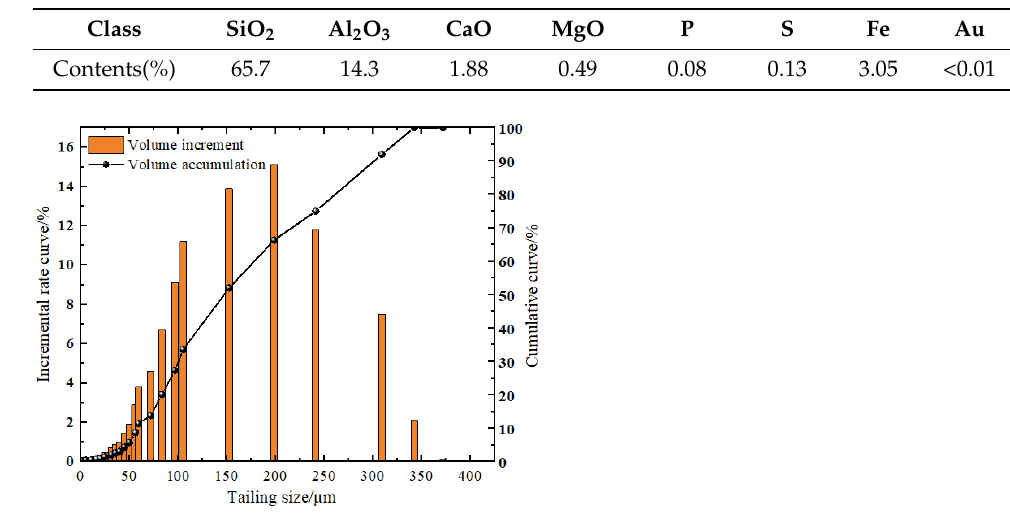
Figure 1. Particle size distribution curve of tailings.